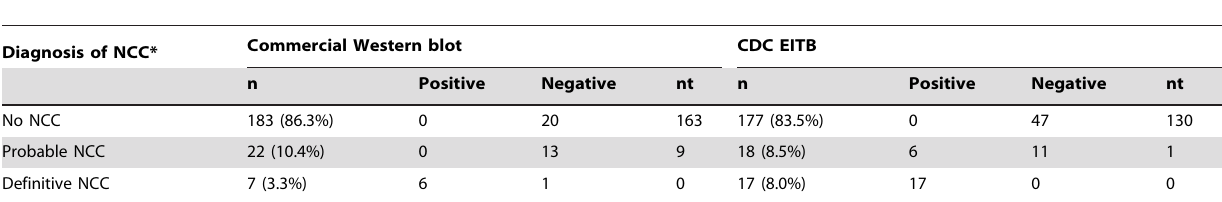
Table 3. Diagnosis of neurocysticercosis according to Del Brutto et al. using two different antibody tests.